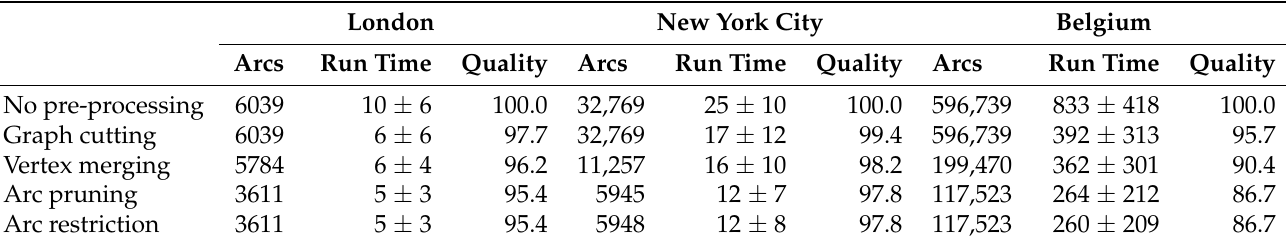
Table 3. Impact of graph